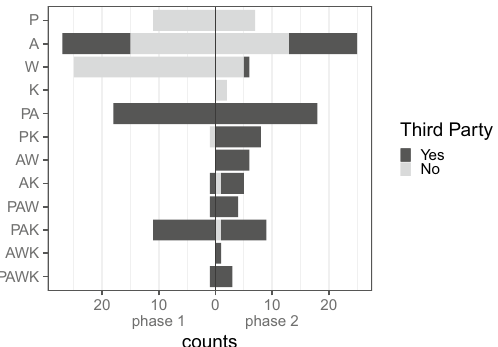
Fig. 5 Graphical representation of distribution of combination of role structures with presence of third parties, in Phase 1 and